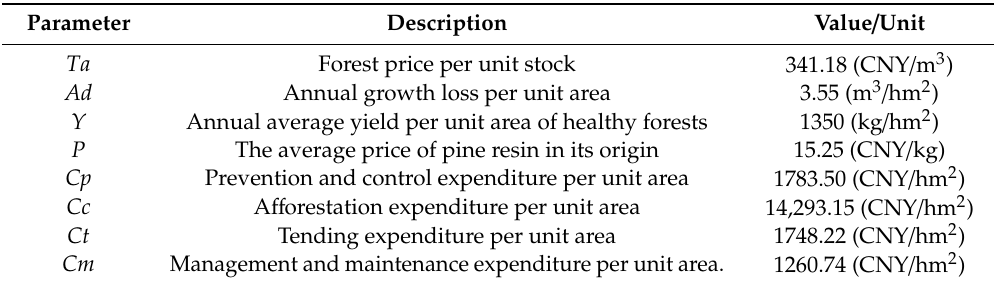
Table 2. Parameter description